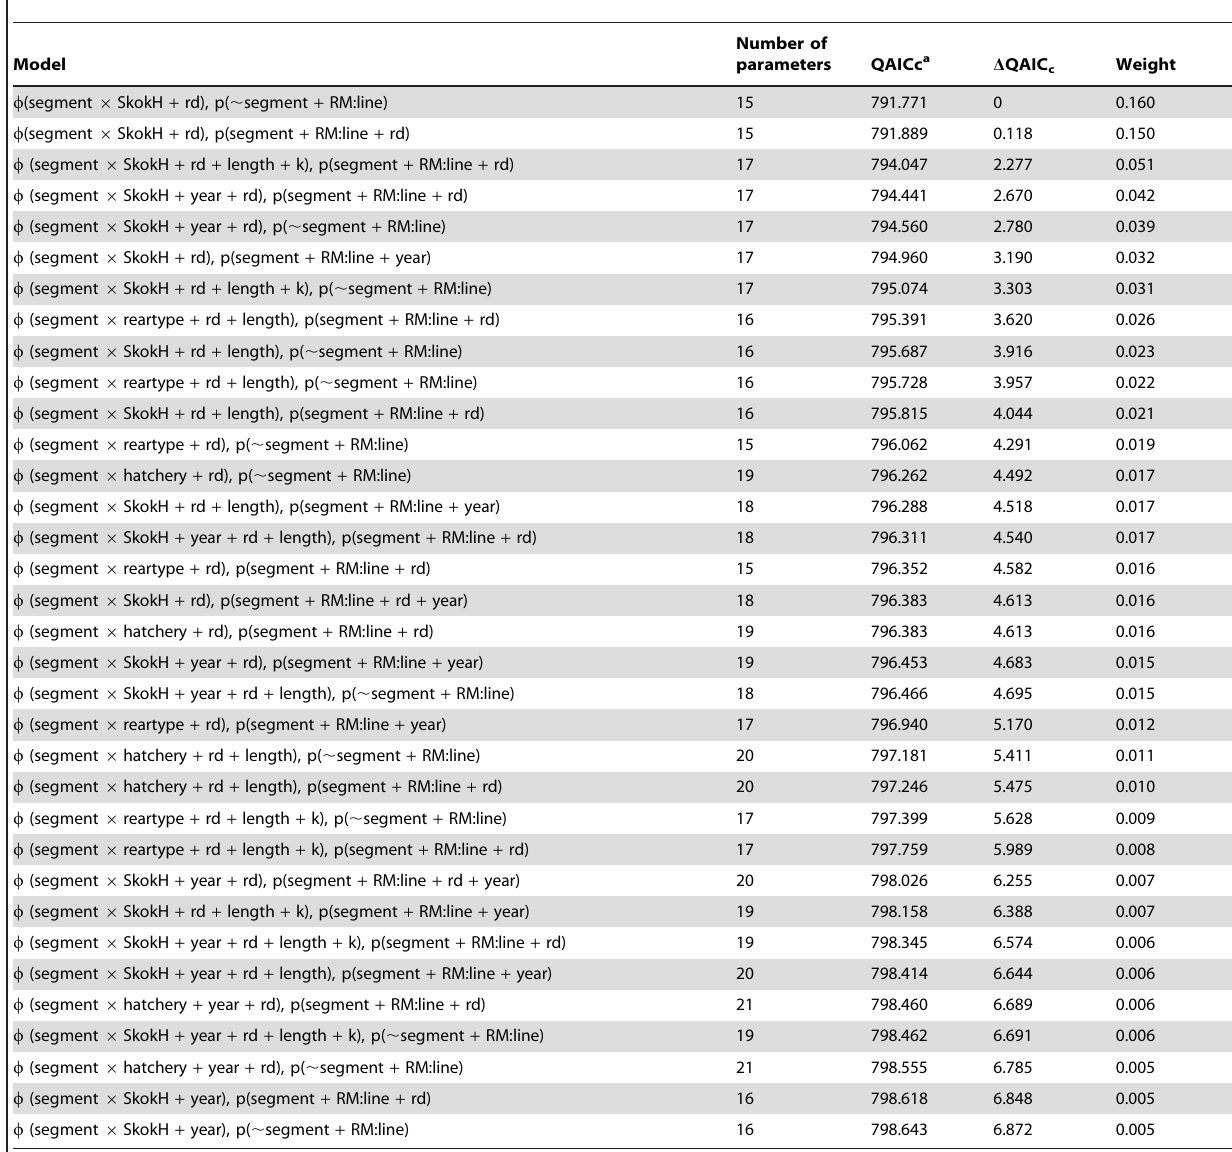
Table 3. Program MARK detection and survival probability modeling results (top 35 models shown).